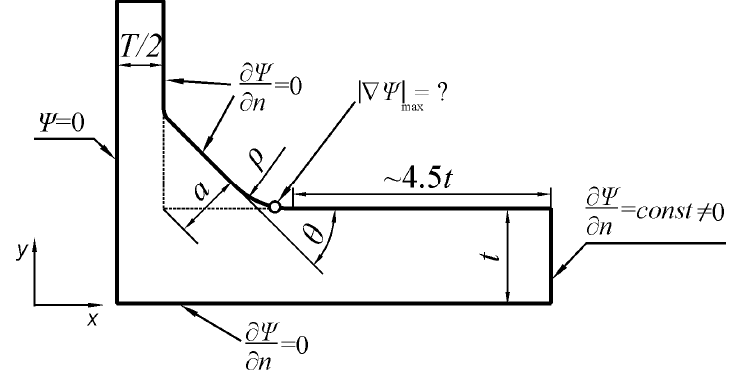
Figure 5. Shape and boundary conditions of the numerical FEM model for shearing load. Nominal uniform heat flux q nom = 1 W/m 2 was applied over the right-hand edge of the body, while zero temperature was applied to the left end along the plane of symmetry of the joint. Since the upper face and the lower face of the joint are free from external shearing loads, they have to be insulated in the thermal model. It is clear that the shear stress components, τ xz and τ yz , given by Equations (9):